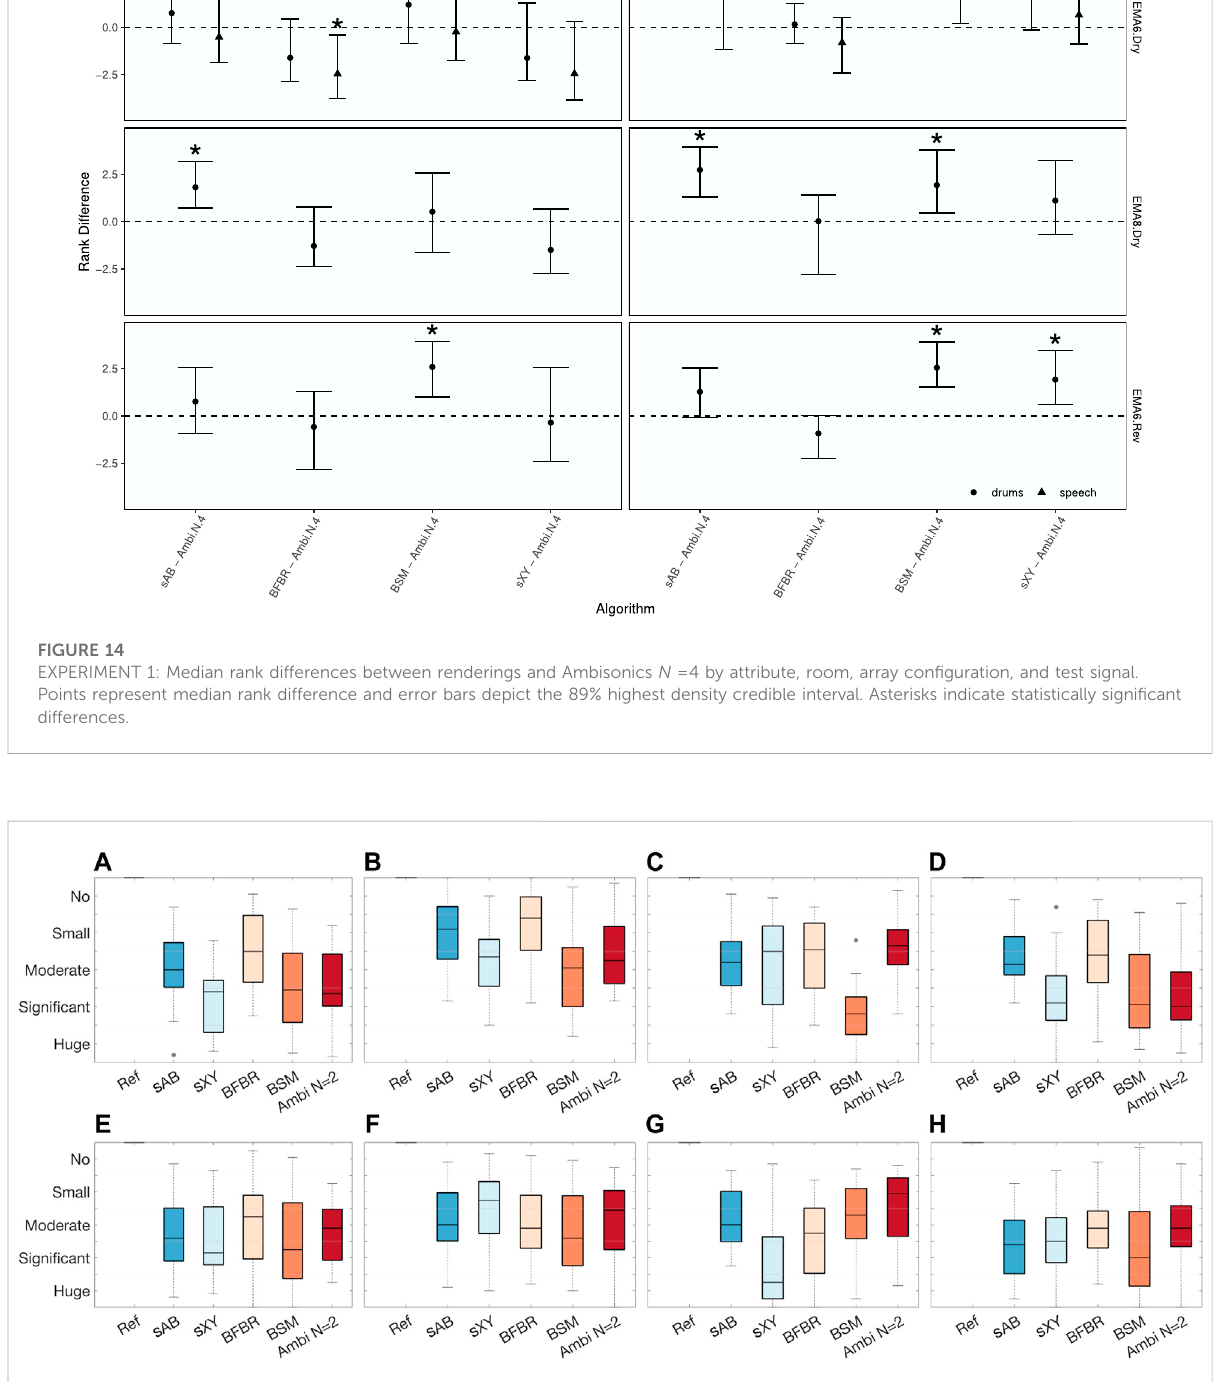
FIGURE 15 EXPERIMENT 2: Boxplots of the inter-individual variation in the MUSHRA points for each MUSHRA page separately. (A) Timbre: dry spk1 drums, (B) Timbre: dry spk1 speech, (C) Timbre: dry spk2 drums, (D) Timbre: reverberation spk1 drums, (E) Spaciousness: dry spk1 drums, (F) Spaciousness: dry spk1 speech, (G) Spaciousness: dry spk2 drums, (H) Spaciousness: reverberation spk1